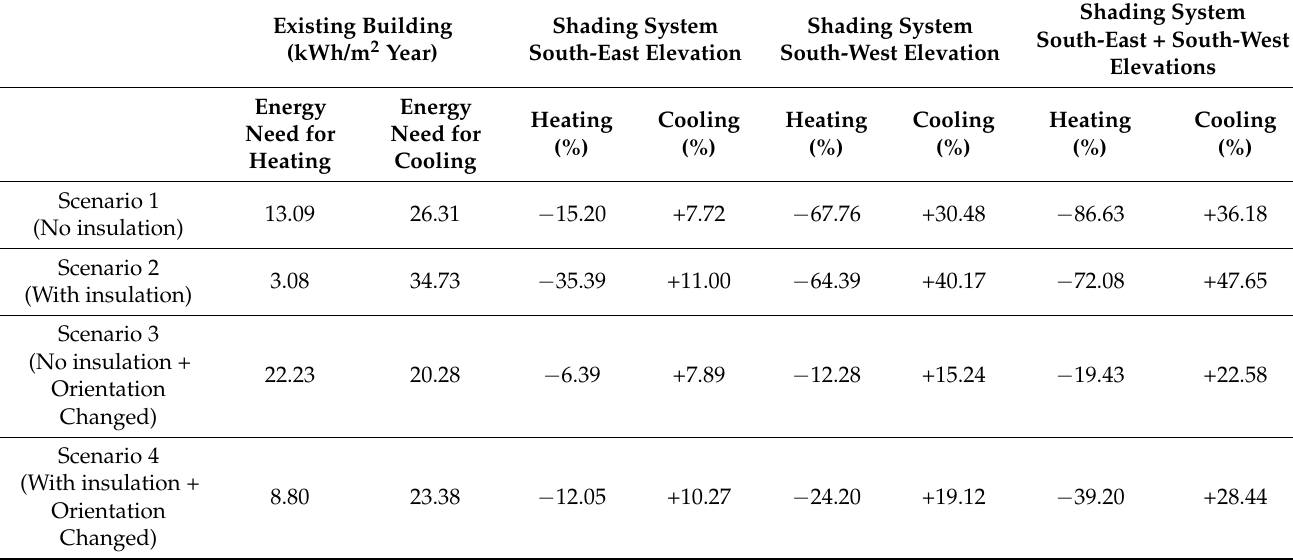
Table 2. Calculation of the improvement (%) of the shading system with the data obtained with CYPETHERM HE Plus.